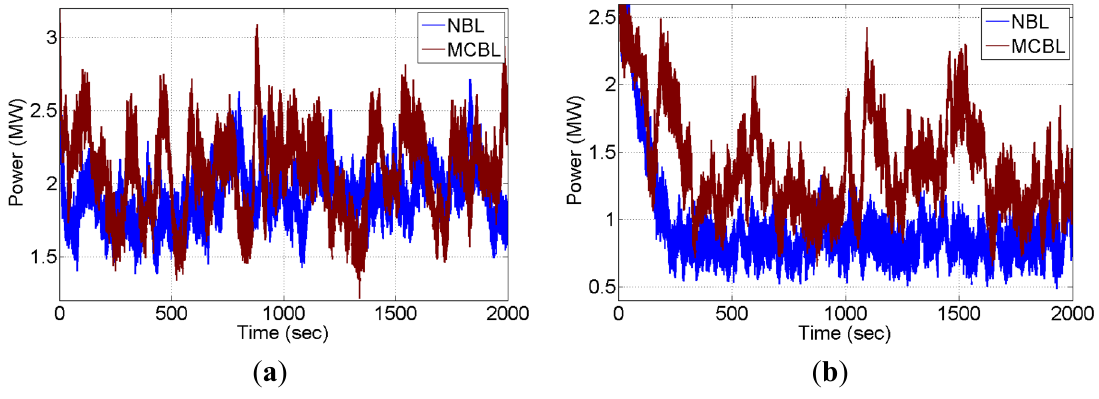
Figure 7. Time series of power (Turbine-Turbine Interaction Problem, V Wind = 8 m/s). ( a ) Turbine 1; ( b ) Turbine